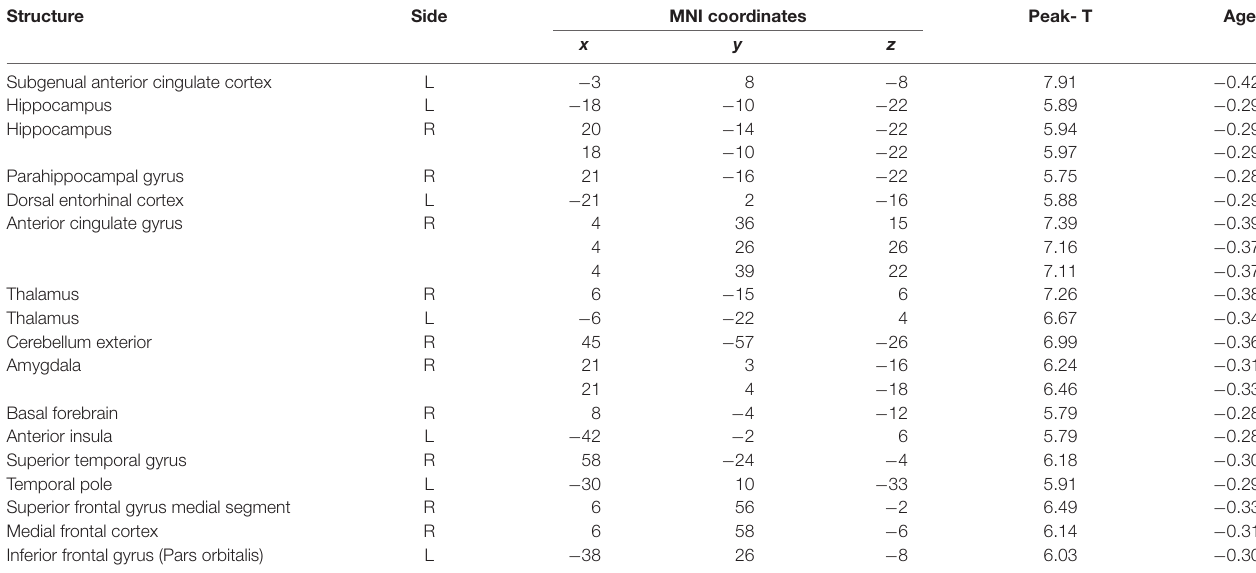
TABLE 4 | Correlations between age and ROIs. Structure